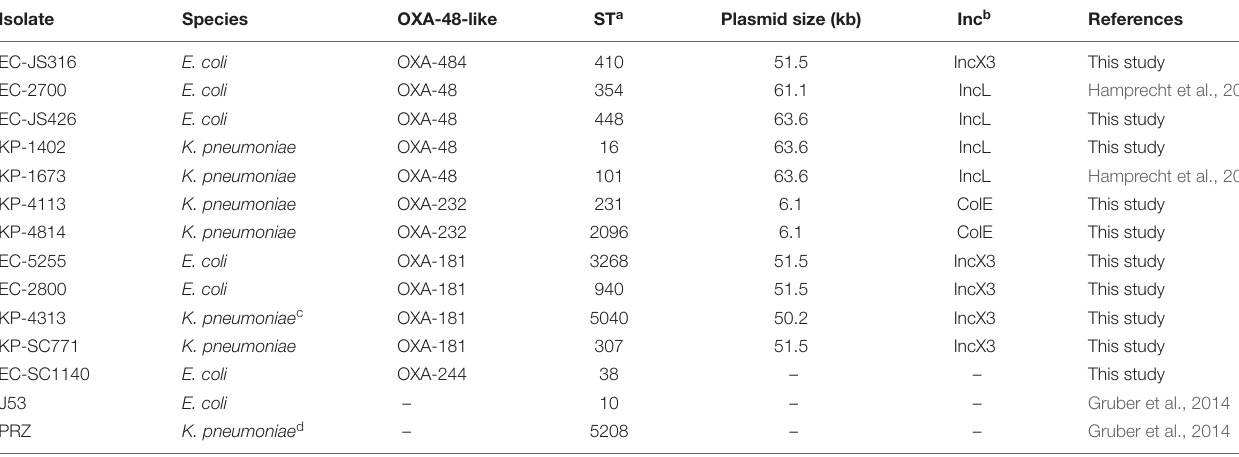
TABLE 1 | Characteristics of clinical isolates harboring OXA-48-like carbapenemases and recipient strains E.coli J53 and K. quasipneumoniae subsp. quasipneumoniae PRZ.